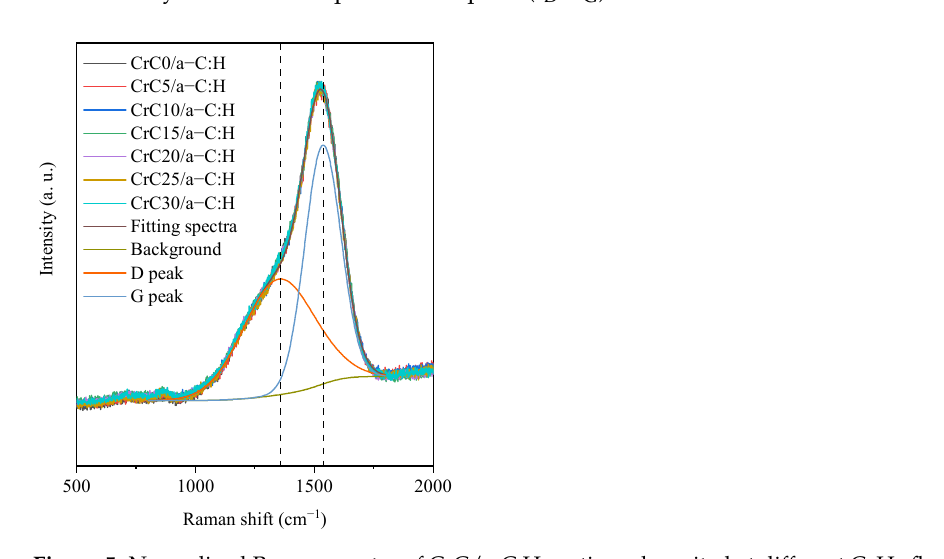
Figure 5. Normalized Raman spectra of CrC/a-C:H coatings deposited at different C 2 H 2 flow rates.